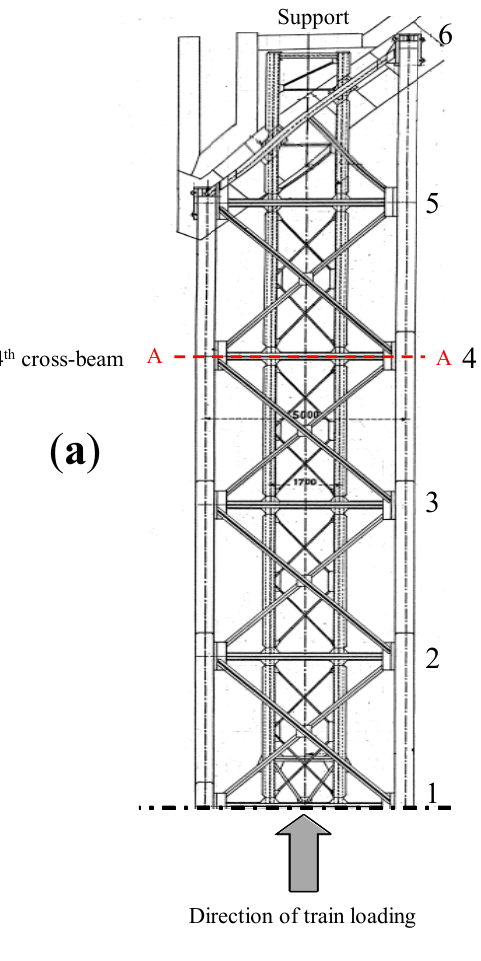
Figure 11. ( a ) Top view of the bridge indicating location of fourth cross-beam; ( b ) Cross-beam geometry; and the measurement plane ( c ) exact position of gauges and ( d ) three magnetic strain